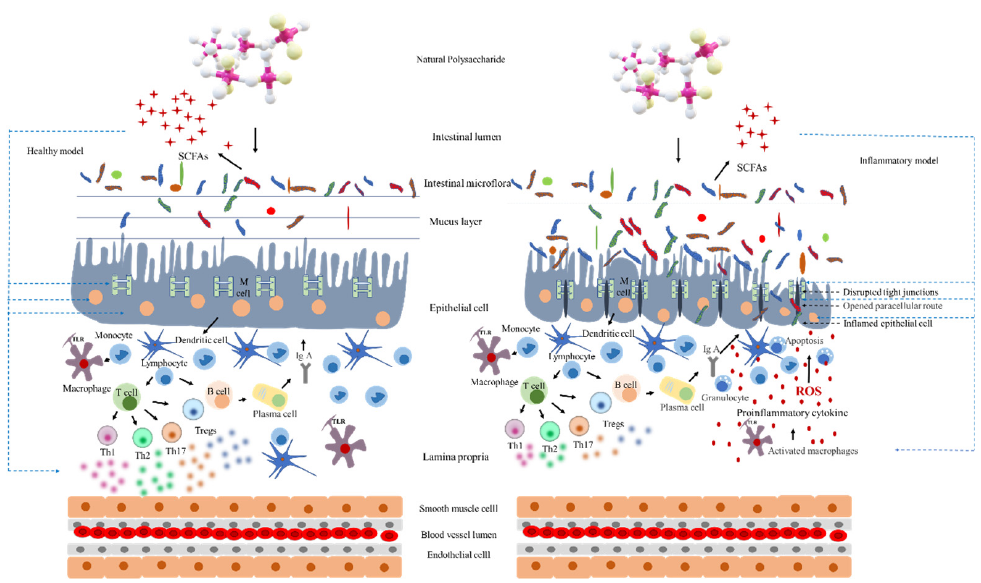
Figure 1. Schematic of mechanisms via which natural polysaccharides (NP) improve inflammatory bowel disease (IBD) through intestinal microbiota. A: Healthy model; B: Inflammatory model. ROS: reactive oxygen species.